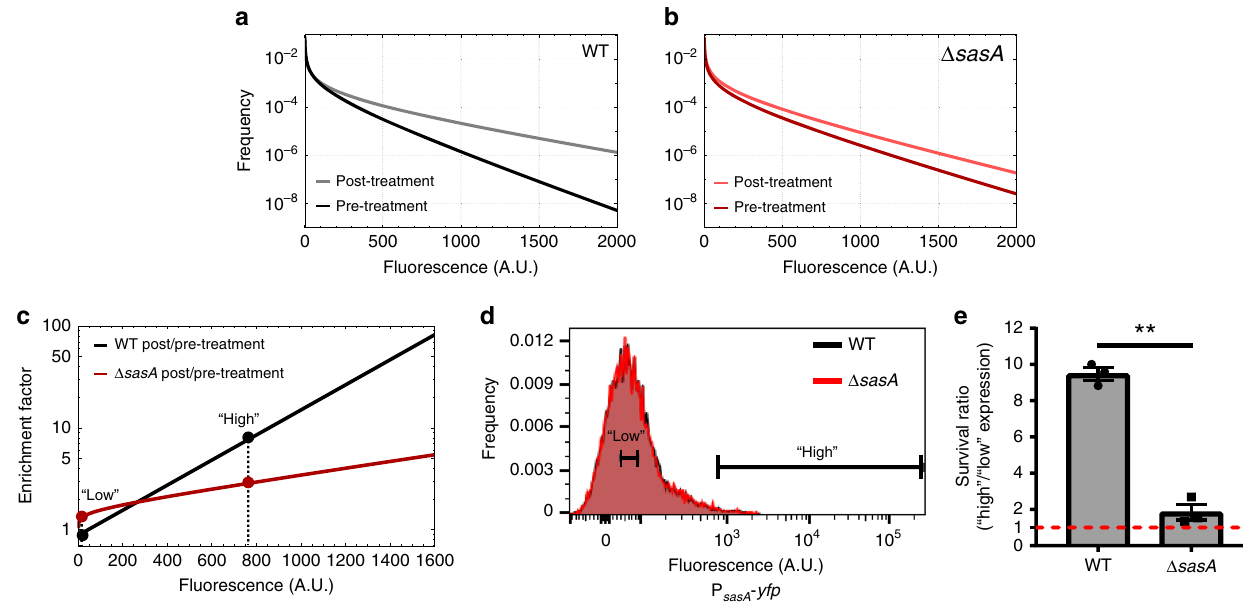
Fig. 4 Cells with elevated sasA expression preferentially survive antibiotic treatment. a Auto fl uorescence-free distributions of sasA expression before (dark gray) and after (light gray) cipro fl oxacin treatment in an otherwise WT background based on the data shown in Supplementary Fig. 10A. b Auto fl uorescence-free distributions of sasA expression before (dark red) and after (light red) cipro fl oxacin treatment in a Δ sasA background based on the data shown in Supplementary Fig. 10B. c Enrichment plot following antibiotic treatment for WT and Δ sasA populations. For each genotype in a , b the frequency of cells with a given level of P sasA - yfp after antibiotic treatment was normalized against the corresponding frequency prior to antibiotic treatment. Dashed lines and dots indicate the average values used in d , e . d Histograms of P sasA - yfp fl uorescence in WT (black) and Δ sasA (red) backgrounds measured by fl ow cytometry prior to sorting into “ low ” (4.1 ± 1.8) or “ high ” (779.5 ± 134.9) expression groups (relative mean ± SEM, 3 experiments). Each histogram is comprised of data obtained from ~3.0*10 4 events and is from a representative experiment used in e . e Relative survival of the “ high ” and “ low ” expression populations in d after treatment with cipro fl oxacin for ~3.5 h as in a , b . Bars indicate the mean survival ratio of the “ high ” to “ low ” expressing populations, lines indicate the SEM. The data shown represents 3 independent experiments (paired t -test, p -value ~ 0.009, **). The red dashed line indicates a survival ratio of 1, indicating no